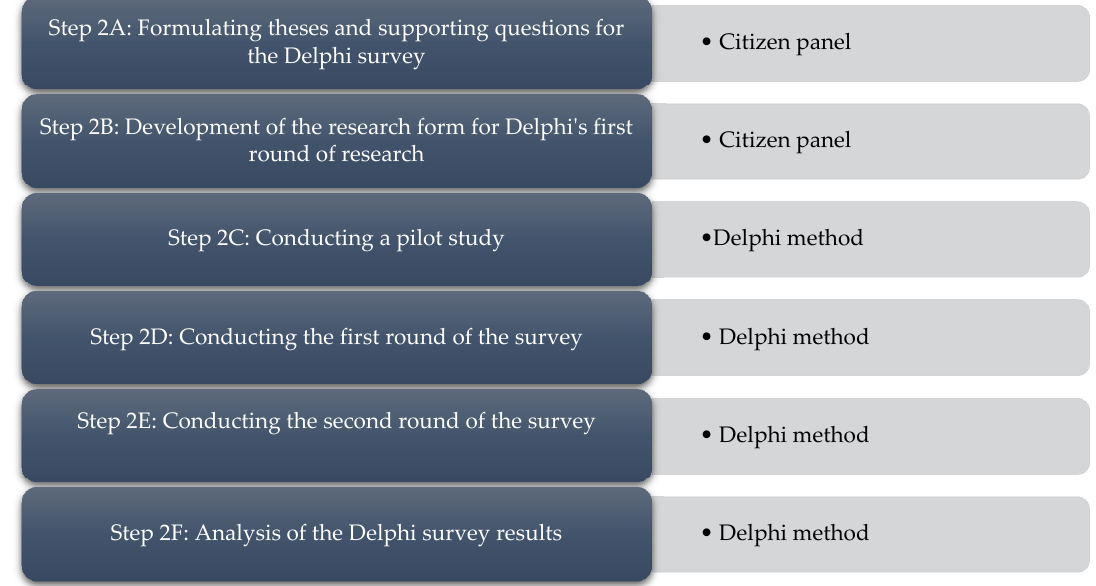
Figure 5. Operationalisation scheme for Stage 2 of the research process.